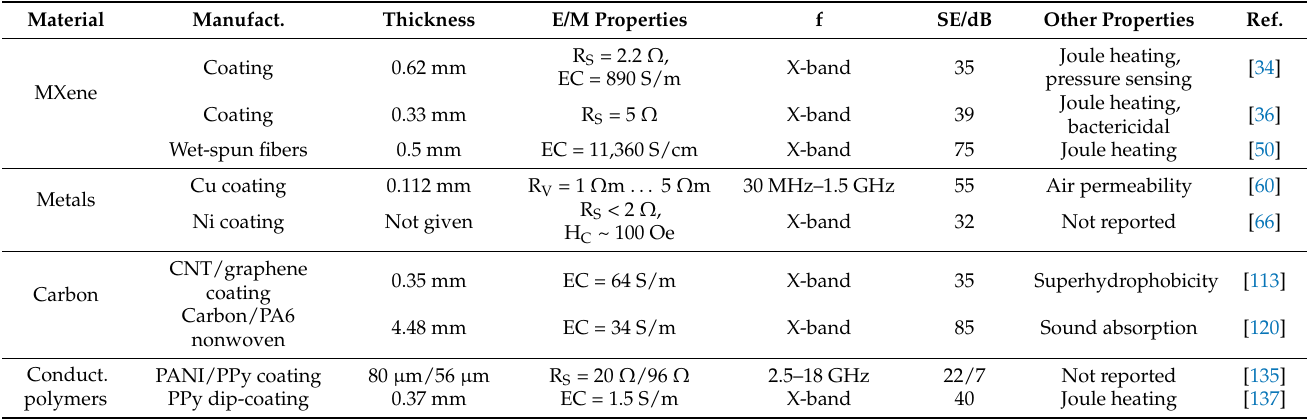
Table 1. Comparison of textile fabrics with EMI shielding properties. E/M: electrical and magnetic; f: frequency; R S : sheet resistance; R V : volume resistivity; EC: electrical conductivity; H C : coercive field; SE: shielding effectiveness (max.